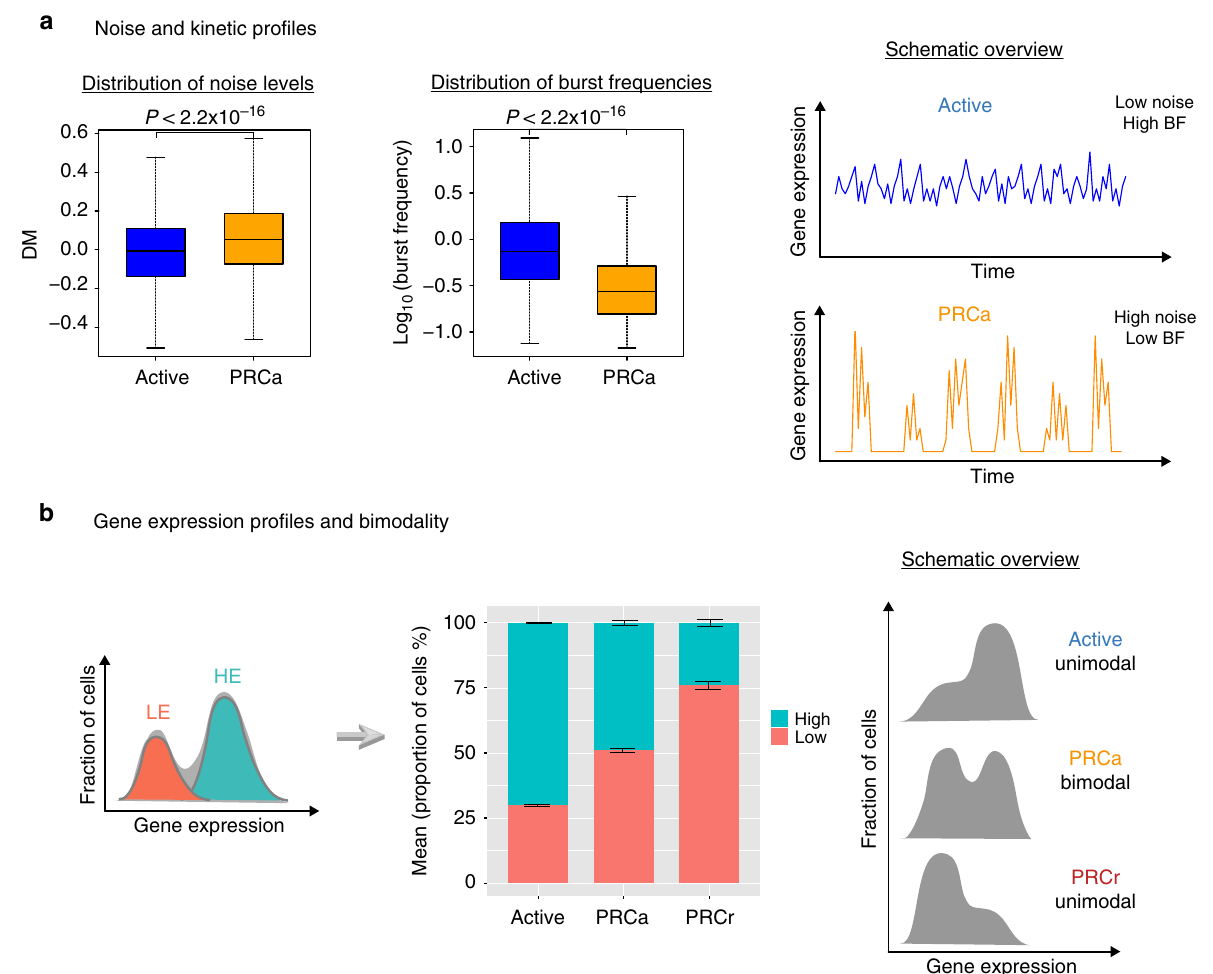
Fig. 2 Stochastic gene expression of PRCa and active genes. a Comparison of PRCa and active genes reveals that PRCa genes are more variable with lower burst frequency levels than active genes ( P < 2.2 × 10 − 16 by the two-tailed Wilcoxon rank sum test). Gene expression variation is represented by DM values. b Expression pro fi les of PRCa genes show bimodal patterns. The distribution of a gene with bimodal expression is assumed to be expressed as a mixture of two normal distributions (LE and HE states; upper panel ). PRCa genes have mixed cell states (on average 49% in HE and 51% in LE) indicating they are either in active state (i.e., active RNAPII and no PRC marks) or in repressed state (unproductive RNAPII and with PRC marks) consistent with cellular heterogeneity, suggested in Brookes et al. 5 Error bars represent